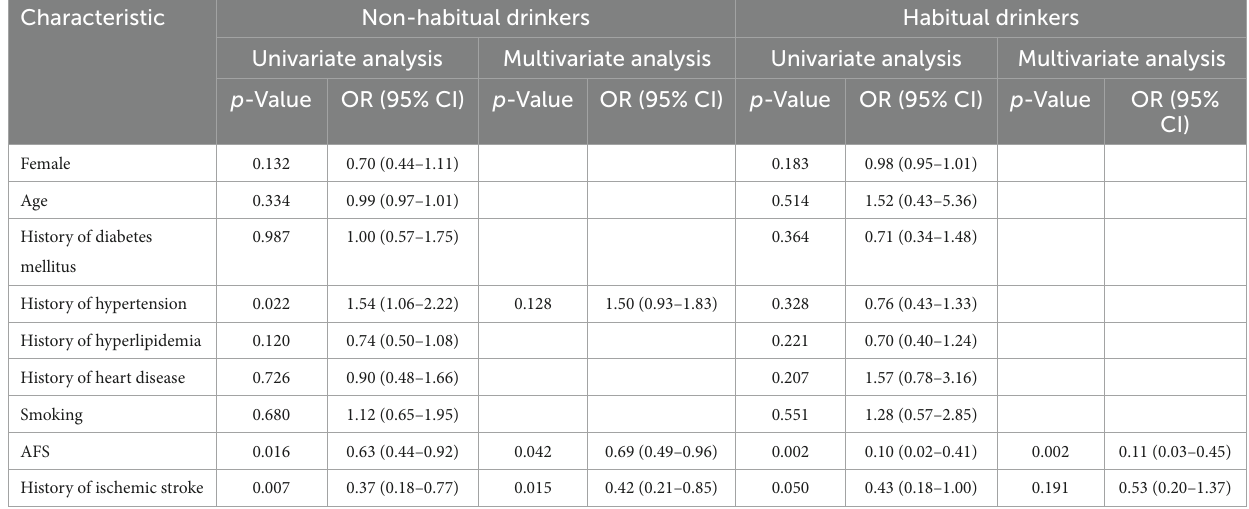
TABLE 6 Univariate and multivariate regression analyses for rupture of intracranial aneurysm in patients with and without a drinking habit.